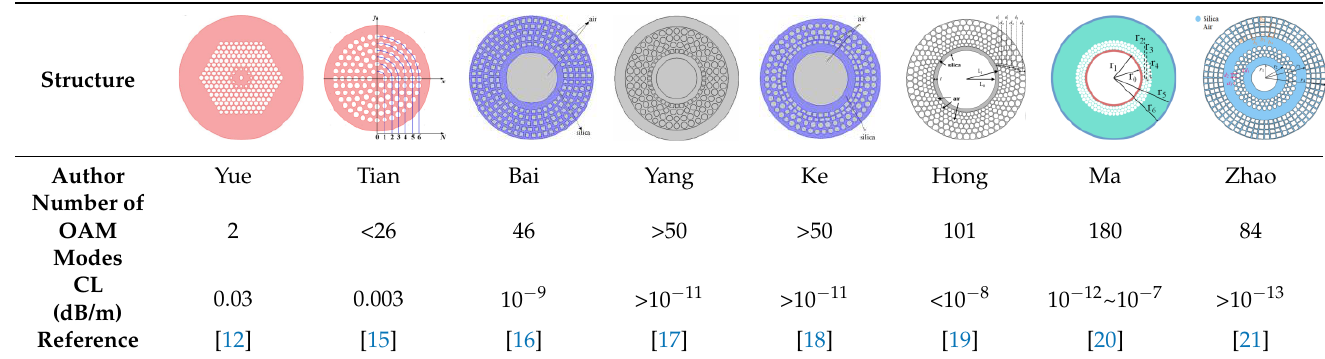
Table 1. The development of PCF.